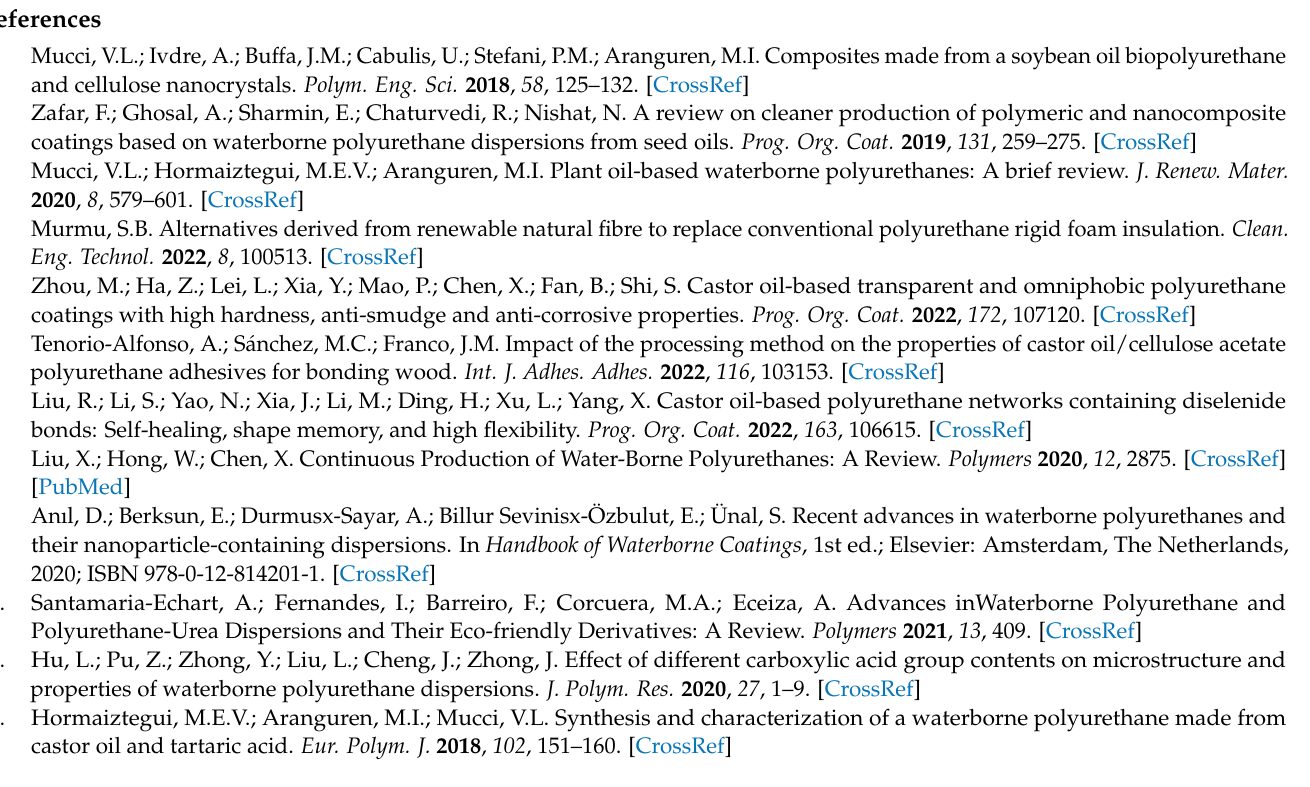
Table S4: Statistical analysis for assay solubility and swelling in toluene; Table S5: Water contact angle with representative images of the